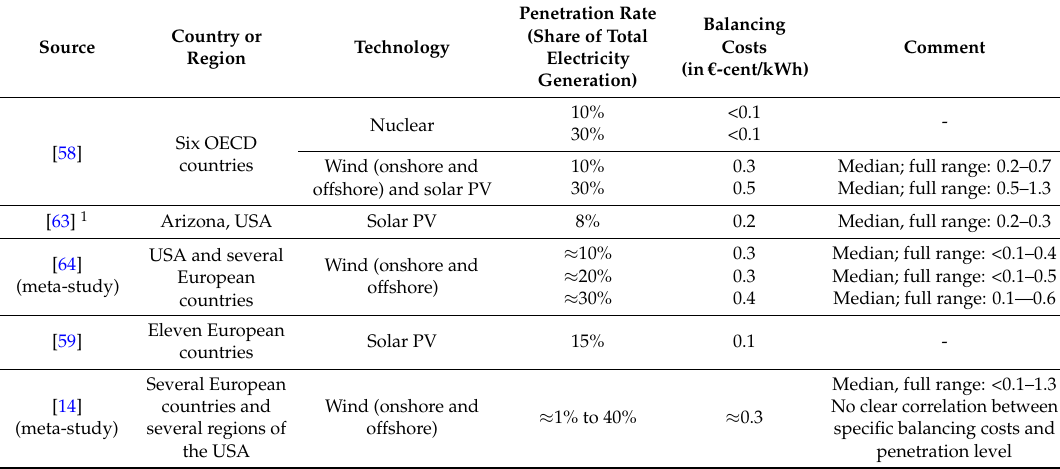
Table 3. Additional specific balancing costs of different electricity generation technologies at varying penetration rates according to several